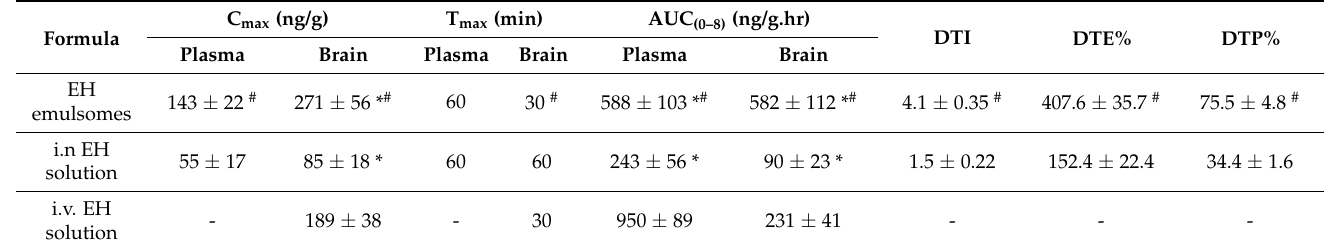
Table 6. EH hydrobromide pharmacokinetic parameters in plasma and brain.